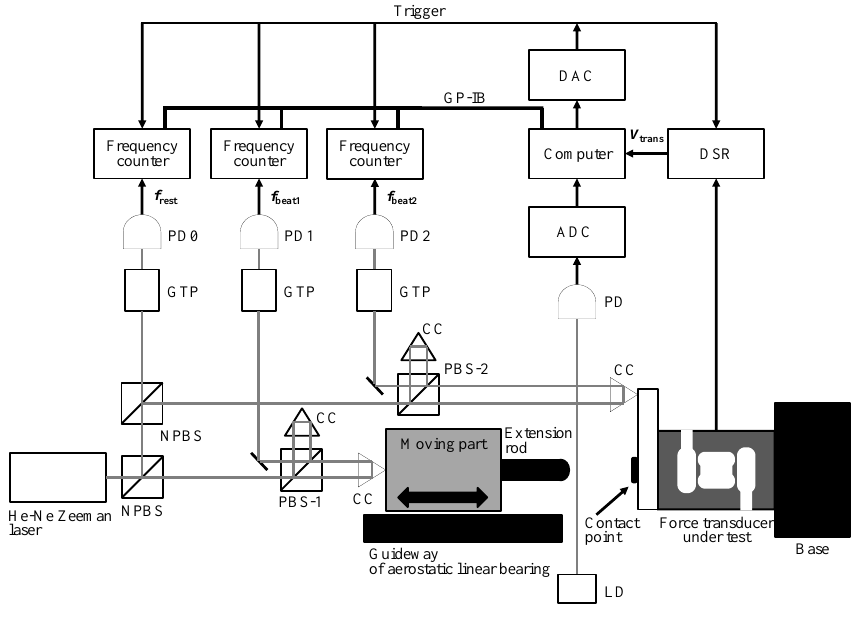
converter, DSR = Dynamic strain